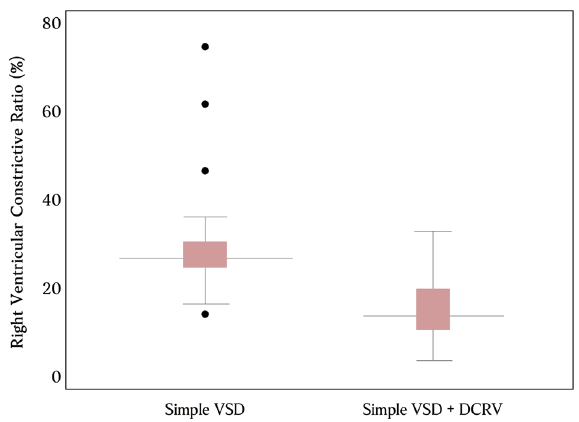
Figure 2. Boxplots showing data distribution of right ventricular constrictive ratio in percentages in simple ventricular septal defect (VSD) patients with or without double-chambered right ventricle (DCRV). Statistical significance was achieved with independent samples t-test ( p < 0.001).